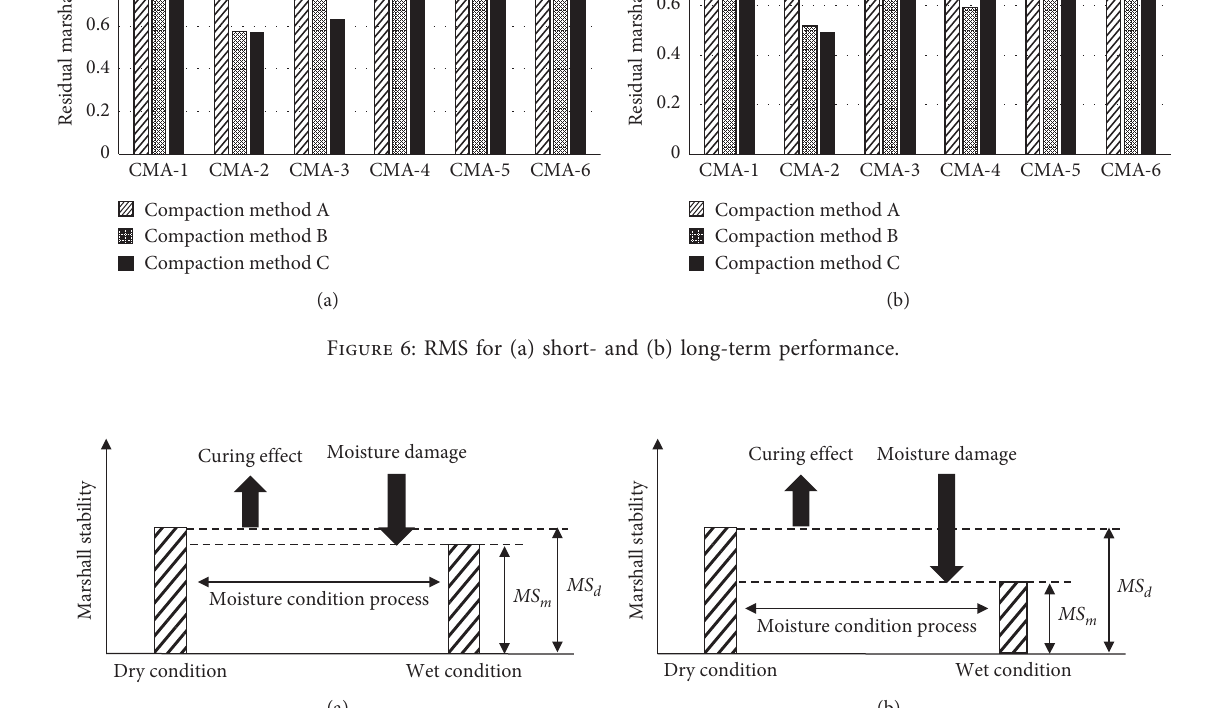
Figure 7: Schematic of the curing and moisture damage effect on Marshall stability during the moisture condition process.